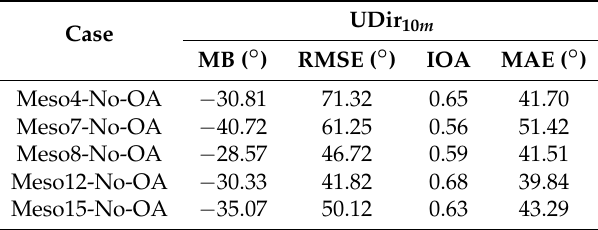
Table A6. Statistical measures for 10-m wind direction in mesoscale simulations performed without nudging. UDir 10 Case